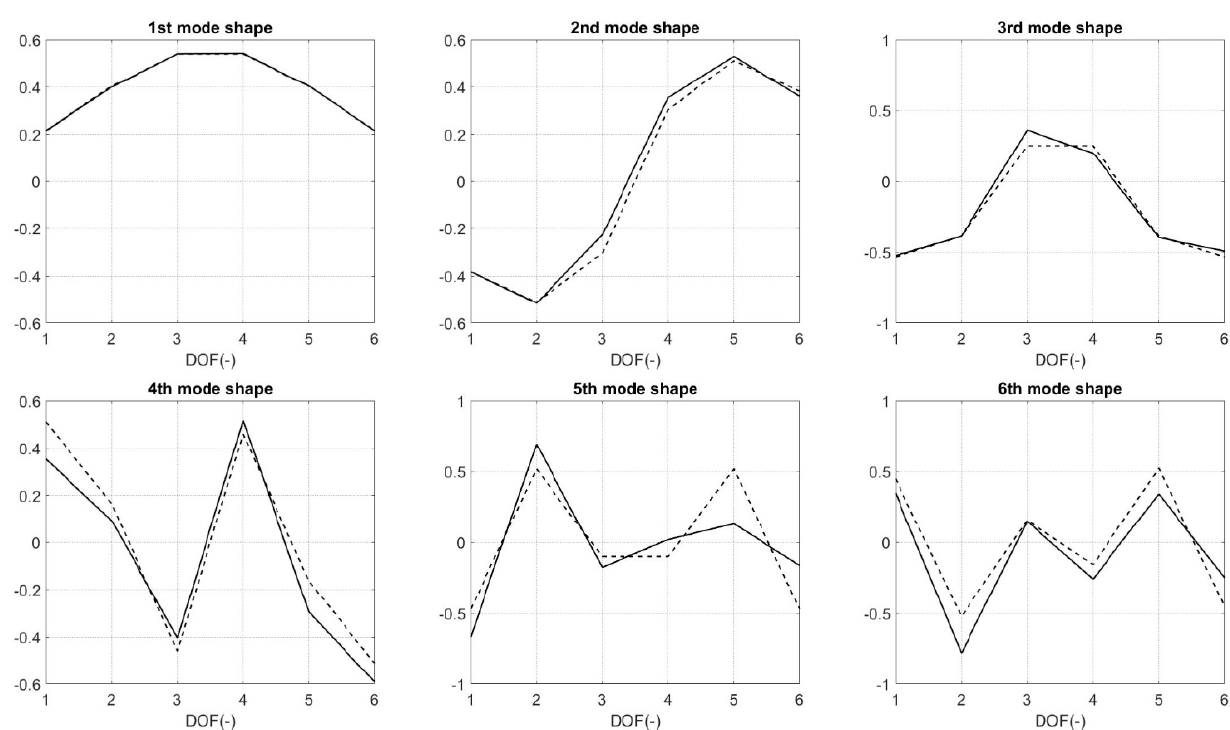
Figure 9. Stabilization diagram of six-DOF chain model with heavy damping.